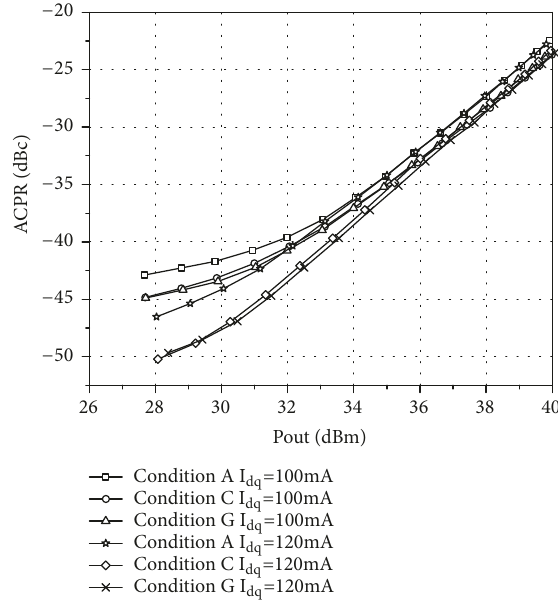
Figure 8: HCI test result of RF LDMOS.